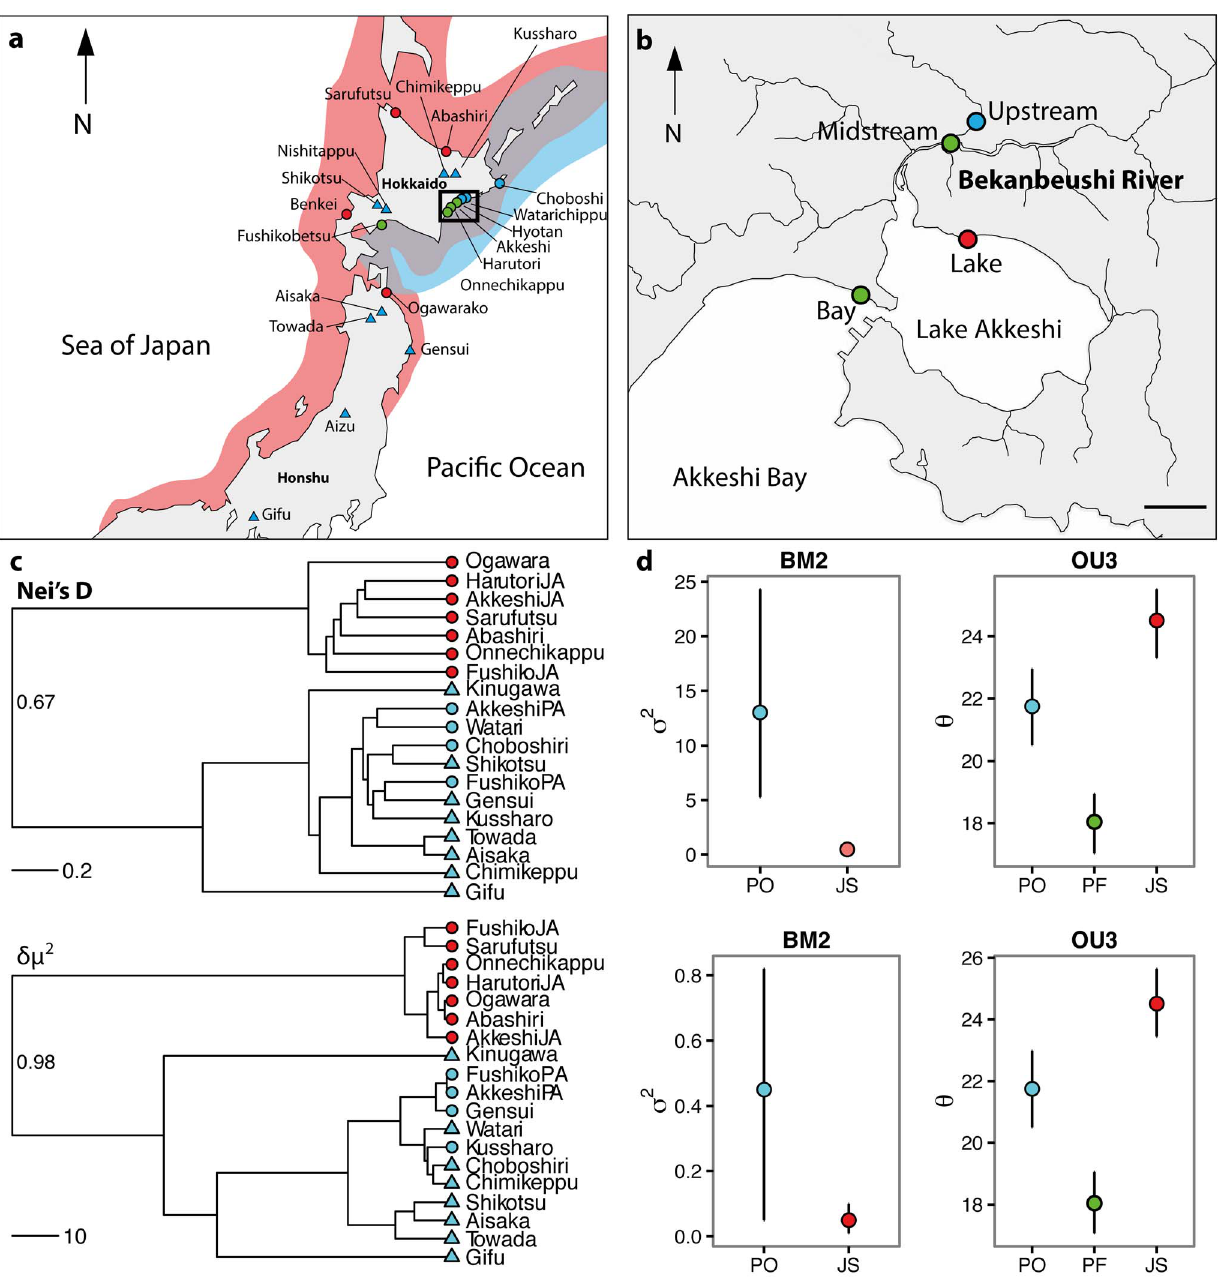
Figure 1. Maps showing a) sampling locations across Japanese archipelago, of Japan Sea (red) and Pacific Ocean (blue) stickleback distributions; red circles indicate allopatric Japan Sea anadromous, blue circles indicate allopatric Pacific Ocean anadromous, green circles denote sites with both forms present, blue triangles represent Pacific freshwater populations, black square indicates location of Akkeshi system in Eastern Hokkaido; b) sampling sites in the Akkeshi system; c) pruned phylogenetic trees for JS and PO populations where both stable isotope and gill raker data was available based on Nei’s D and dm 2 ; bootstrap values based on 200 bootstrap iterations for JS and PO split are shown at tree root, see S2 for full bootstrap values on full phylogeny; d) mean rates of phenotypic evolution under BM2 ( s 2 ) and OU3 (e`) models ( ¡ bootstrapped 95% confidence intervals) for gill raker number. The upper panels are based on the Nei’s D tree, while the lower panels are based on the dm 2 tree.